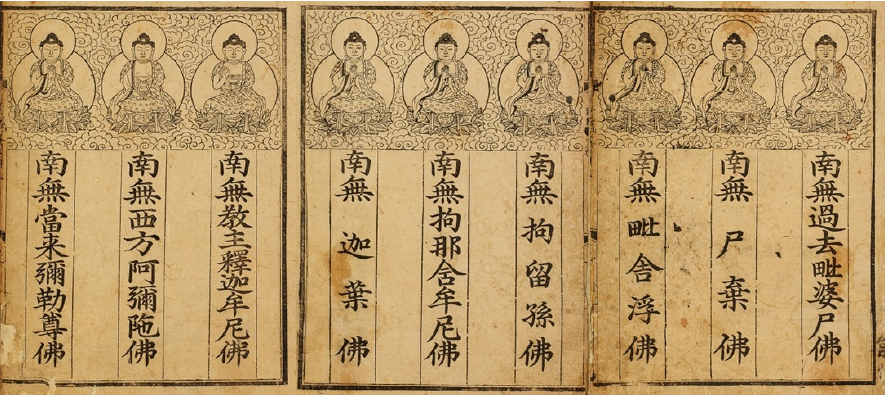
Figure 6. Contrition in the Name of Amitabha Buddha, Joseon dynasty (1474), 22.5 × 18.5 cm, National Museum of Korea (Photo by National Museum of Korea).